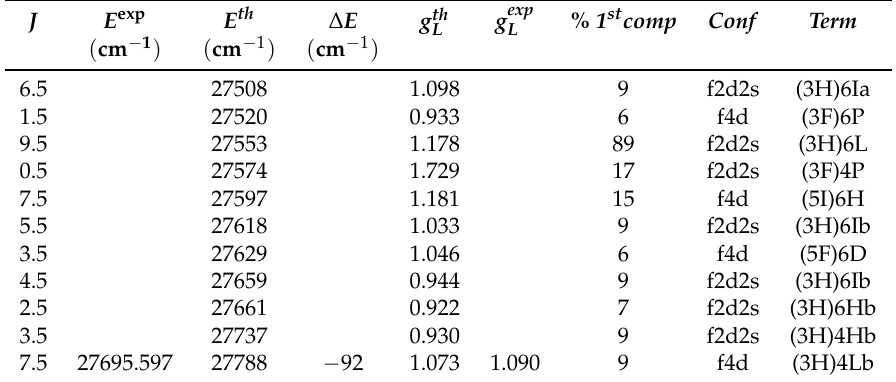
Table 7. Adopted parameters (in cm − 1 ) for even parity configurations 5 f 3 7 s 7 p and 5 f 3 6 d 7 p of U